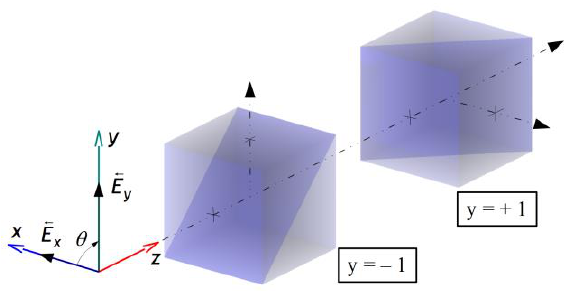
Figure 3. Definition of the global coordinate reference system and the binary operator y with respect to the incident plane of the polarising beam splitter. If the polarising beam splitter orientation parameter y = +1, the vibration of the horizontal linear polarisation with vector E x is parallel to the plane of incidence, while for y = – 1 it is perpendicular.